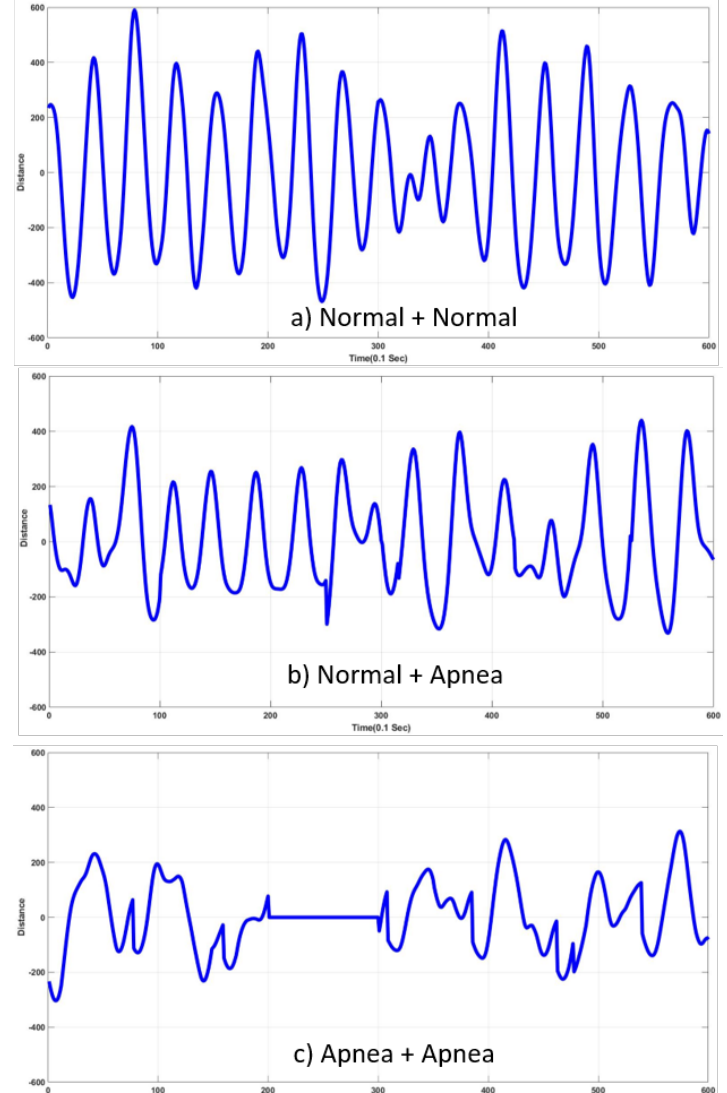
( t ) ; ( b ) S 2 ( t ) ; ( c ) S 2 ( t ) . 2 3 1 provided information to determine the existence c are shown in c